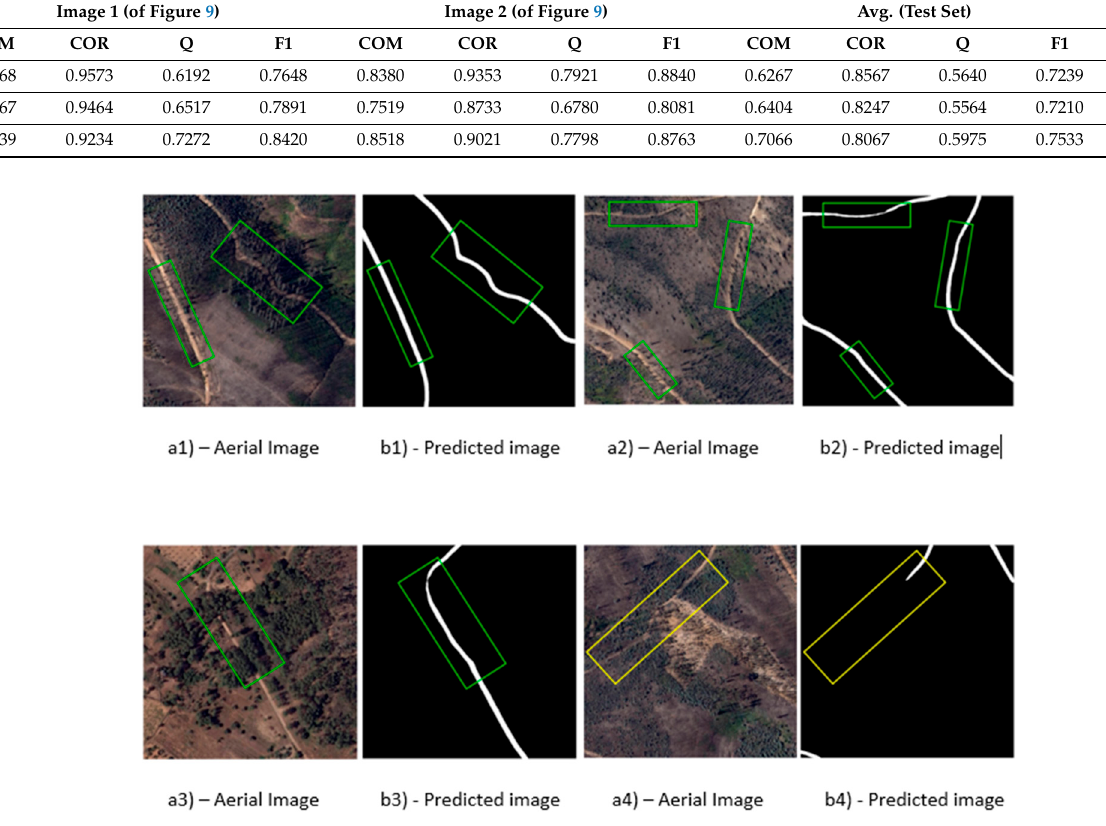
Figure 10. Sample results of rural road detection: ( a1 , a2 , a3 , a4 ) multiple aerial images with different road occlusions; ( b1 , b2 , b3 , b4 ) the predicted roads by the proposed method.